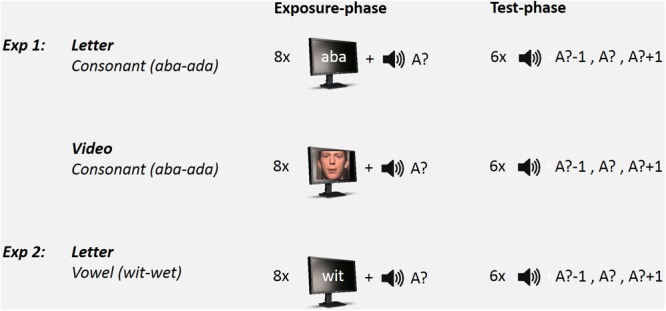
Schematic set-up of the Exposure-Test paradigm (only exposure to ambiguous speech sounds is shown). In Experiment 1, participants were exposed to 8 auditory-visual exposure stimuli followed by 6 auditory-only test trials on an ‘aba’–‘ada’ continuum. Visual stimulus type during exposure consisted of either Text (Letter) or Lipread (Video) stimuli. In Experiment 2, participants were only exposed to Text stimuli and tested on a ‘wit’–‘wet’ continuum.